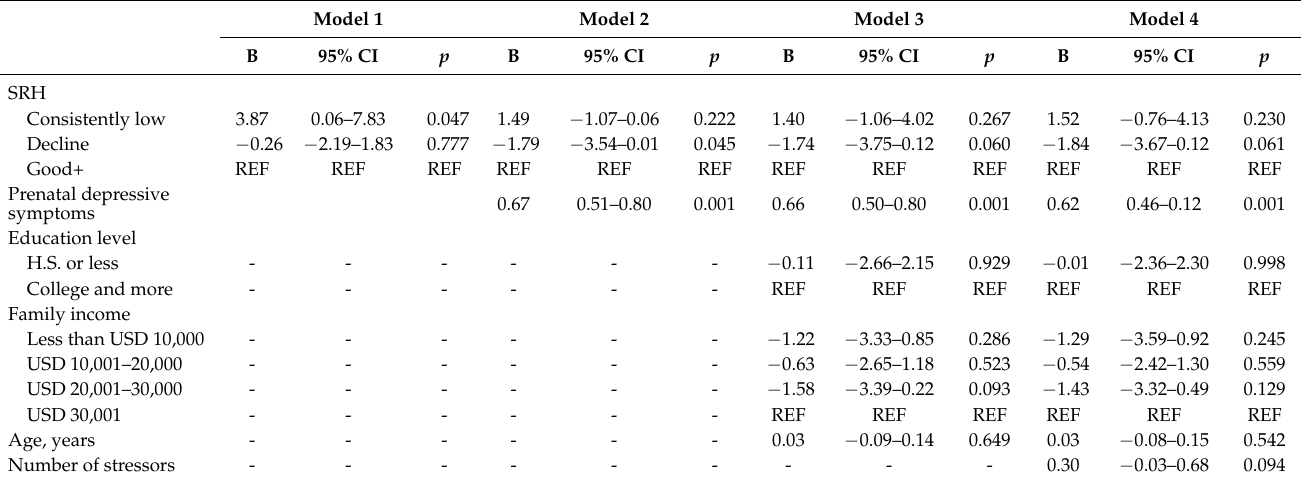
Table 4. Crude and Multiple Adjusted Linear Regression Models Examining Associations between Change in Self-Rated Health and Postpartum Depressive Symptoms at Six Weeks. Model